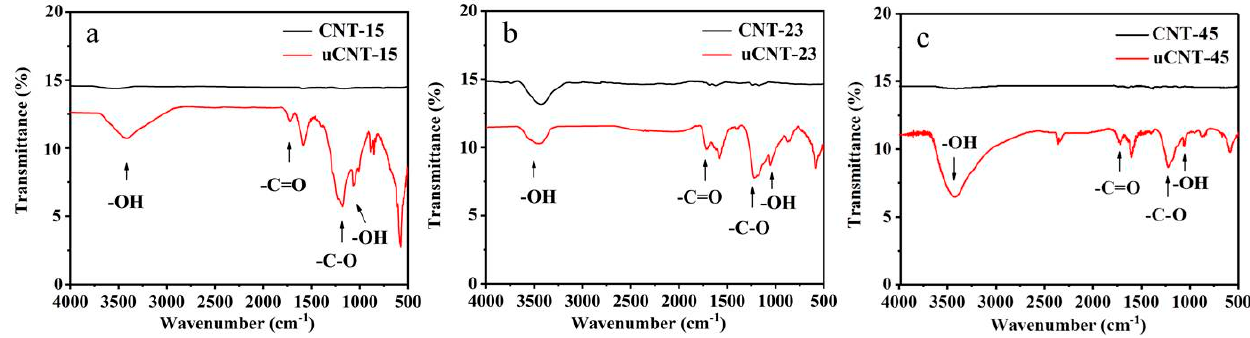
Figure 3. FTIR spectra of CNT-15 and uCNT-15 ( a ), CNT-23 and uCNT-23 ( b ), CNT-45 and uCNT-45 ( c ). The Raman spectra are shown in Figure 4 highlighting the structural changes for CNTs and uCNTs. There were four peaks in the CNTs and uCNTs spectra, which were the D peak around 1349 cm − 1 , the G peak around 1586 cm − 1 , the 2D peak around 2696 cm − 1 , and the 2G peak around 2943 cm − 1 . The first-order Raman scattering peaks were D peak and G peak, and the second-order Raman peaks were 2D peak and 2G peak [23]. After unzipping, the 2D band of the CNTs was significantly weakened in the spectra of uCNTs. This indicates that the structure of uCNTs was more disordered and the number of defects increased during unzipping [24]. The D peak was caused by sp 3 hybridization of CNTs or uCNTs at the defect site, and the G peak was caused by sp 2 hybridization of regularly ordered carbon atoms. Accordingly, the ratio of the intensity of D peak to G peak (R = I D /I G ) gives the degree of structural regularity. The 2D peak was caused by double resonance Raman scattering and had a strong signal in the complete structure. The R values for CNT-15, CNT-23, and CNT-45 were 0.88, 0.75, and 0.64, respectively. After the CNTs were unzipped, their R values rose to 1.13, 1.09, and 1.04, respectively. This indicates that some sp 3 carbon was formed by oxidation, and the larger the R-value, the higher the sp 3 carbon content formed [15]. The Raman spectrum clearly shows the typical sp 3 and sp 2 hybridization corresponding to the defect sites and carbon atoms, re- spectively. Meanwhile, the infrared spectrum presents the composition information of C-O, C=O, -OH, and other functional groups. The resulting consequence demonstrates that the Raman spectroscopy and infrared spectroscopy complement each other. Figure 4. Raman spectra of CNT-15 and uCNT-15 ( a ), CNT-23 and uCNT-23 ( b ), CNT-45 and uCNT-45 ( c ). Figure 5 shows the XRD spectra of CNTs and uCNTs. Table 2 describes the FWHM of all samples around 26° and 43°. Figure 5 shows that two peaks in the XRD spectra of CNTs appeared around 26° and 43°. The peak at 26° corresponds to the graphite-like phase (002) diffraction peak (d 002 = 3.4 Å) and the peak at 43° represents the characteristic diffraction peak of the (100) plane. The XRD spectra of uCNTs were characterized by two characteristic peaks at 26° and 43°. Compared to the characteristic peaks of the CNTs spectra, the peaks of uCNTs were not so sharp. After unzipping, the 002 peak was